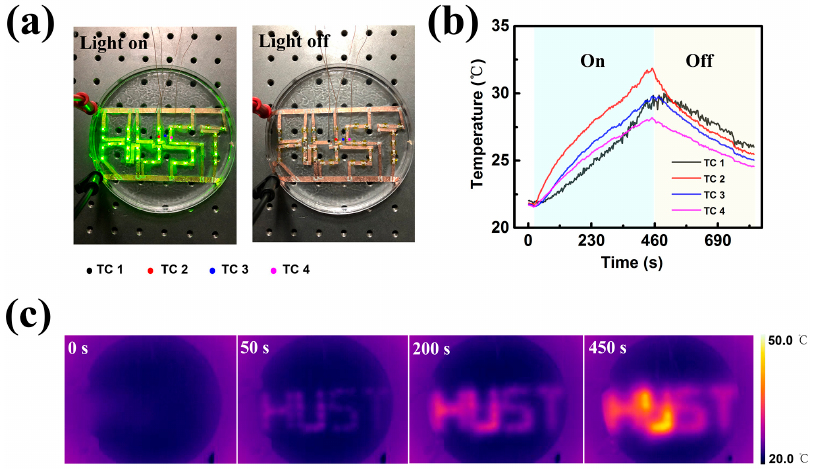
Figure 5. A demonstration of heat dissipation behaviors in the hydrogel-based electronics by K type thermocouples and IR thermal imaging camera. ( a ) Optical image of the electronics with light on and off; ( b )Time dependent temperature on the surface of the hydrogel (1 cm thick) measured by K type thermocouples; ( c ) IR thermal images of the electronics at different heating time.